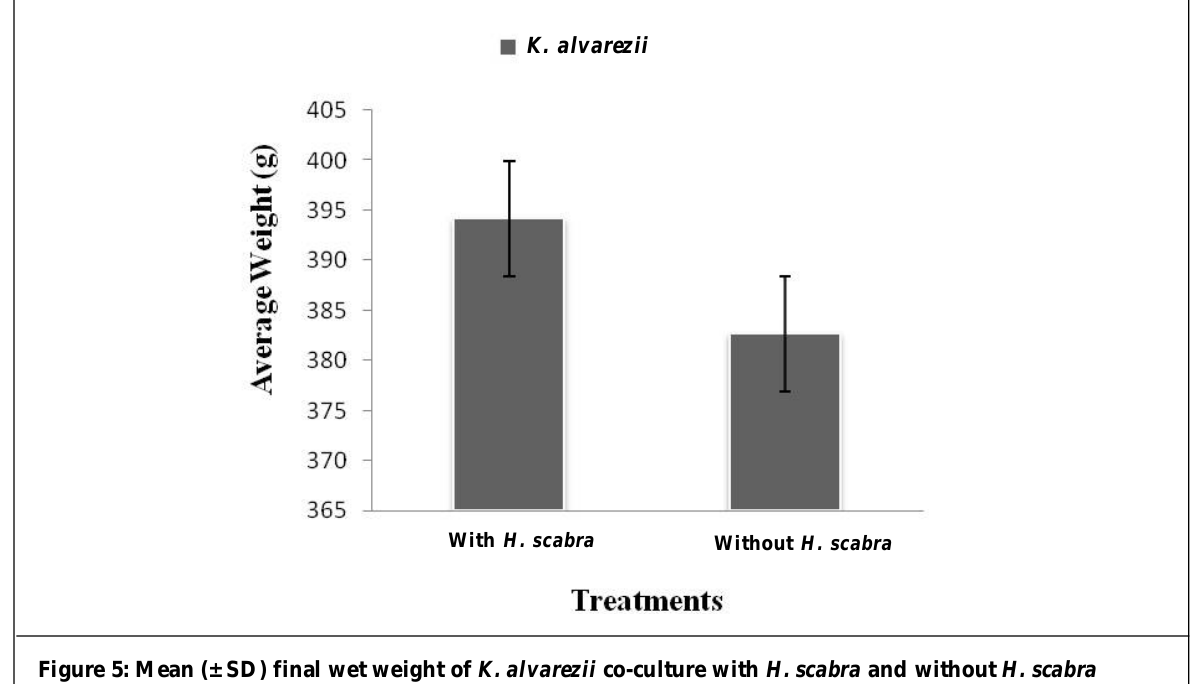
Table 1: Comparison of mean % (± SD) surface organic matter content before and after the experiment among different treatments Mean % Total Organic Matter (TOM) in the Sediments